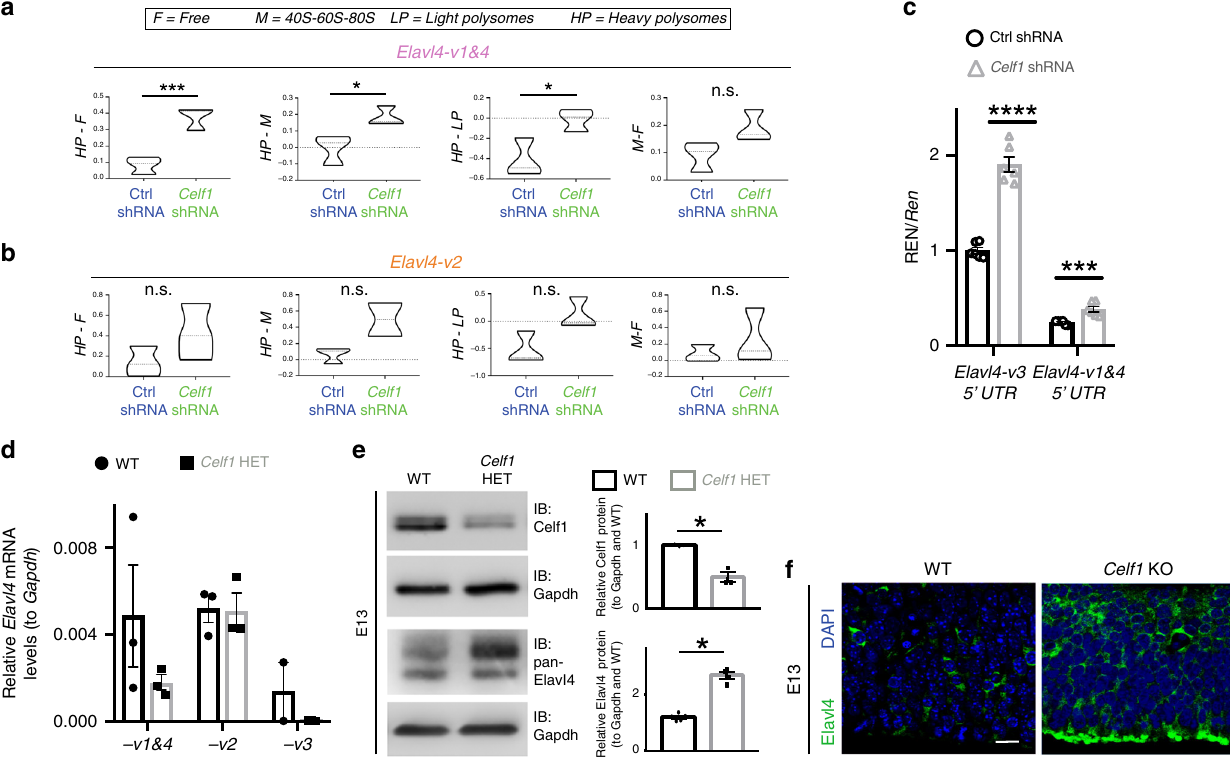
Fig. 5 Celf1 deletion derepressed Elavl4-v3 and Elavl4-v4 translation. a , b Polysome fractionation of N2a cells transfected with either Ctrl shRNA or Celf1 shRNA. Difference between free (F), 40S-60S-80S monosome (M), light polysome (LP), and heavy polysome (HP) fractions are represented for Elavl4- v1&4 ( a ) and Elavl4-v2 ( b ). This graph plots mean difference for each condition; a higher mean difference means a greater abundance in the minuend ( n = 3 fractionations, each fractionation was from one 10 cm plate transfection). Statistics: Welch ’ s t -test. *** p < 0.001. * p < 0.05, n.s. = not signi fi cant. c , N2a cells cotransfected with Ctrl shRNA or Celf1 shRNA plasmids and Elavl4-v3 or Elavl4-v1&4-5 ′ UTR s cloned upstream of Renilla. Same assay as in Fig. 4. Multiple T-tests. * p < 0.05, *** p < 0.001. d qRT-PCR determined levels of different Elavl4 isoforms in E13 WT and Celf1 HET neocortices. Data represent the mean and SEM. N = 3 separate spins with 6 brains per spin. Data normalized to Gapdh . e (left) Western blot for WT and Celf1 HET neocortices at E13 ( n = 9 neocortices). (right) Densitometry quanti fi cation of Western blots. Data represent the mean and SD. Data normalized to Gapdh and then to WT. Statistics: Student ’ s t -test. * p < 0.05. f Neocortical VZ at E13 of WT ( n = 6 animals) and Celf1 KO ( n = 2 animals). IHC for pan-Elavl4 (green). DAPI shown in blue. Scale bar: 40 μ mRNAs (Supplementary Fig. 6d, f, h), but there was no change in Celf1 in mice reduces viability in a background-strain dependent splicing nor in decay (Supplementary Figs. 5b, 6c, e, g). manner 36,37 . While steady state levels of Elavl4-v2 did not change, Elavl4-v1&4 and -v3 mRNA decreased in Celf1 HET (Fig. 5d), Collectively, our results indicate that a decrease in Celf1 contrasting the increase in Elavl4 protein expression at E13 derepresses Elavl4 mRNA translation. (Fig. 5e). Low amounts of mRNAs paralleled by a high level of To determine the effect of Celf1 on Elavl4 in vivo, we corresponding protein expression has been reported in multiple compared E13 WT mice to Celf1 heterozygous ( Celf1 HET) systems 3,10,11,38,39 . From the Celf1 KO neocortices that we littermates. Celf1 HETs were analyzed because global deletion of